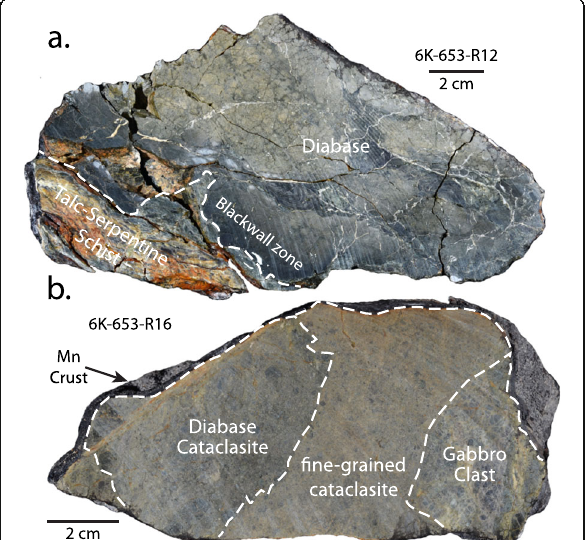
Fig. 31 Selected samples collected on Shinkai 6500 Dive 653 on the 57° 21 ′ E Fault Face (Fig. 29c). a Heavily fractured, chloritized, greenschist facies diabase in contact with talc-serpentine schist from the fault gouge at the lip of the bench above the high-angle normal fault at 57° 22 ′ E. Note “ blackwall ” zone in the dike margin due to reaction with the enclosing sheared serpentinite. Apparent boudinage of the diabase may actually reflect the development of a dike-finger structure due to melt intrusion approximately perpendicular to the cut face of the sample through sheared serpentinite. b Polymict cataclasite with coarse gabbro and diabase clasts in a fine-grained matrix from detachment fault footwall on the bench above the normal fault. Note the thin 1 – 3 mm manganese crust on the upper side of the sample